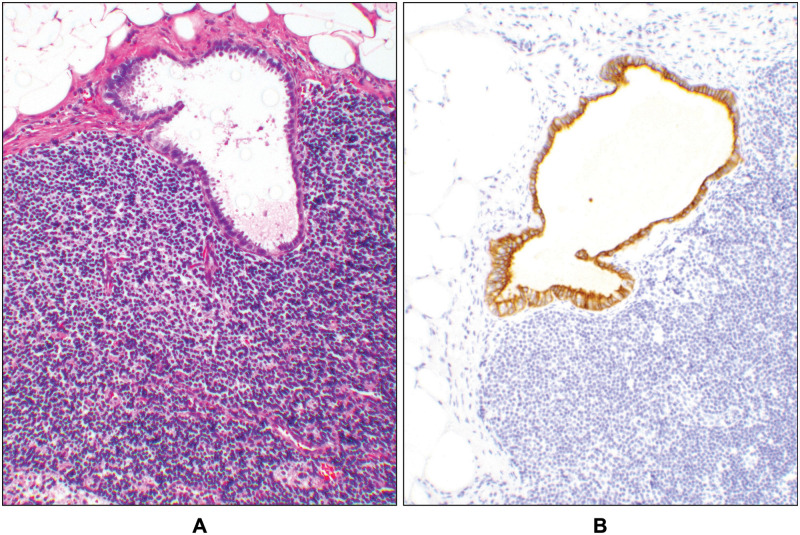
Endosalpingiosis.A negative sentinel lymph node with endosalpingiosis in a patient with complex atypical hyperplasia (case # 6, S1 Table). (A) The photomicrograph shows a cystic glandular structure in the lymph node that is lined with fallopian tube-type ciliated epithelium on hematoxylin and eosin (H&E) stain. (B) Immunohistochemical stain for cytokeratin highlights the glandular structure at the same location as on the H&E slide (10x objective).